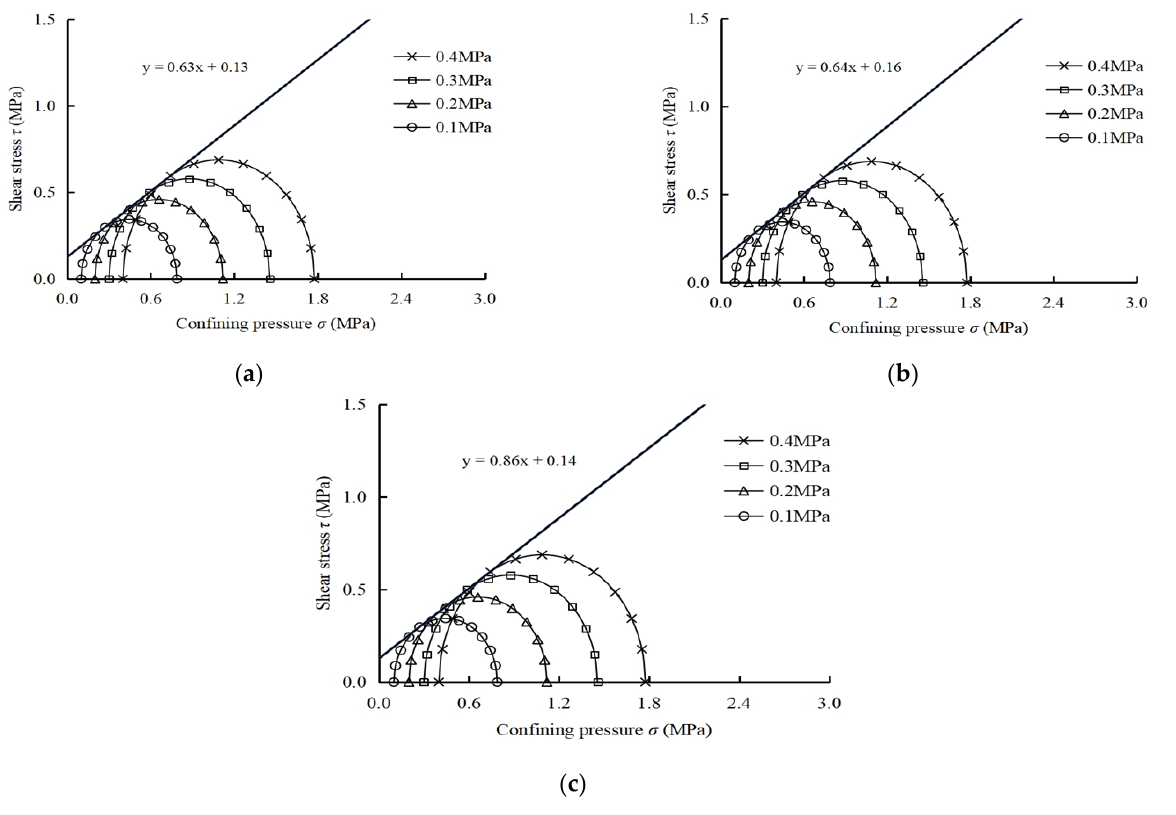
Figure 3. Mohr’s circle. ( a ) LS sample; ( b ) PLS sample; ( c ) FLS sample. Table 5. Strength